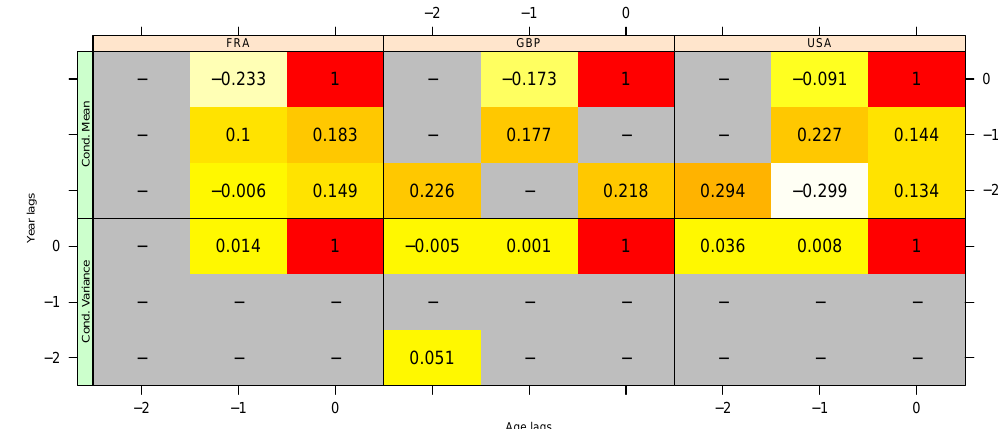
Figure 4. Model selection: Estimation of the parameters for the optimal model, maximizing the penalized QMLE. The grayed area corresponds to parameters that were not selected by the procedure and are excluded from the neighborhoods.